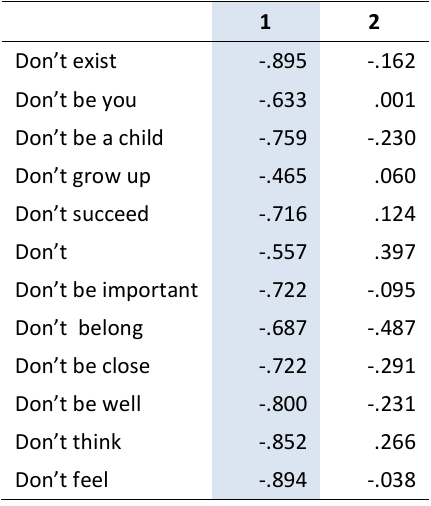
Table 15: Canonical loadings for the injunctions set